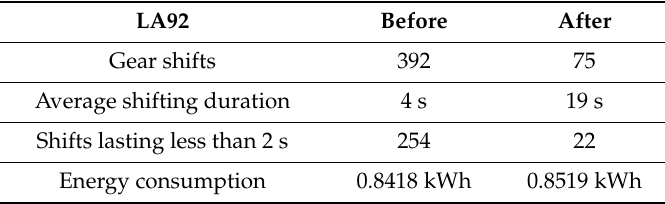
Table 3. Drivability improvement and energy consumption.